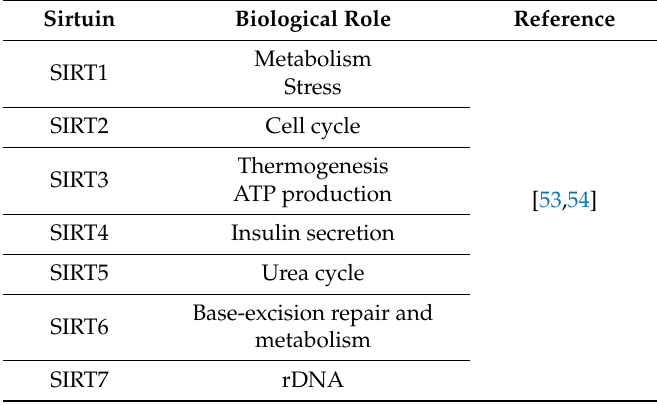
Table 2. Biological functions fulfilled by sirtuins in